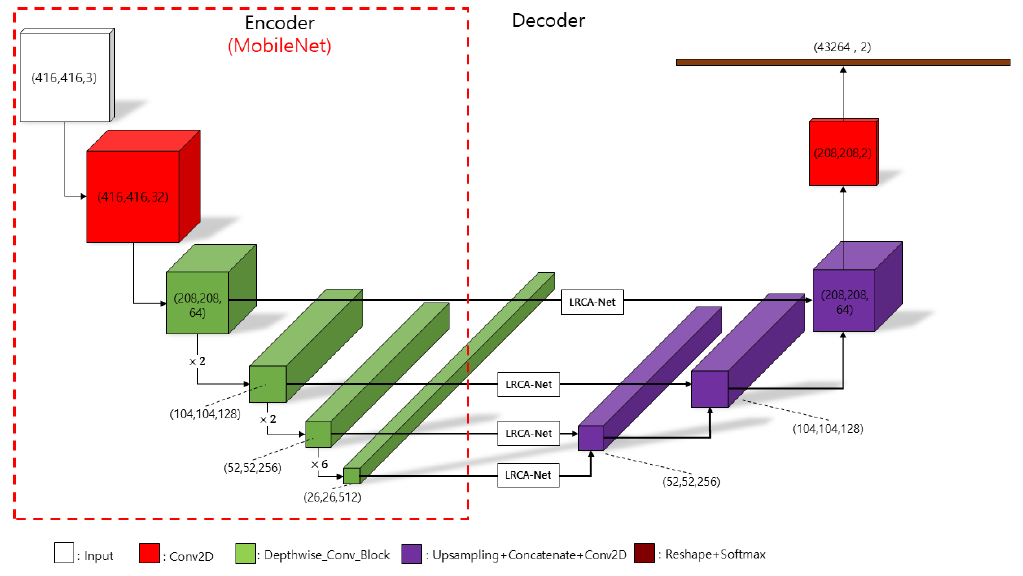
Figure 12. The proposed lane detection network.